Question: Provide a one-line summary of what is displayed.
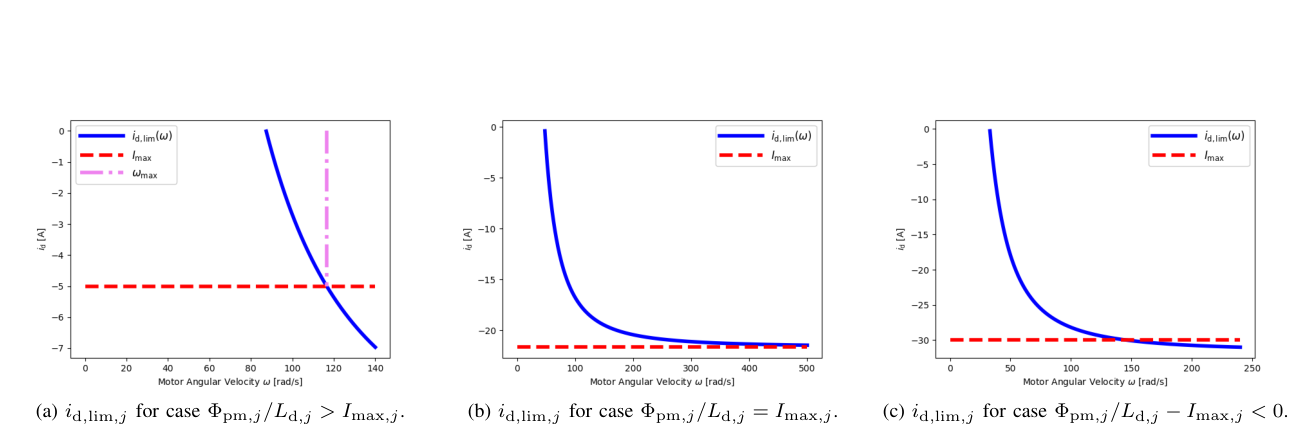
Answer: id,lim,j as a function of ωj in all cases. The blue lines represent the function id,lim,j(ωj); the red dashed lines represent Imax,j; the pink dash-dot lines represent ωmax,j from (52). The intersection in (a) indicates the maximum motor speed constrained by the maximum current Imax,j.